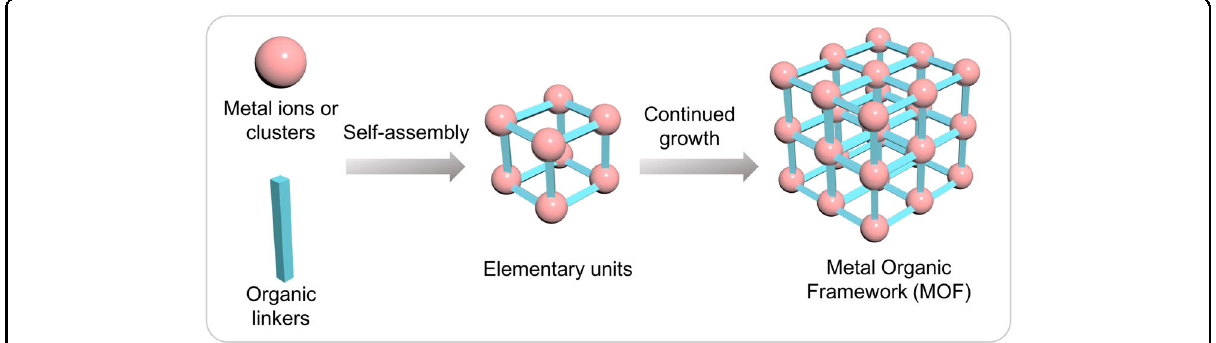
Fig. 8 General synthesis method of the metal – organic framework (MOF). Metal – organic framework are crystalline porous materials consist of a three-dimensional network of metal ions and organic ligands, forming a highly porous material with high surface